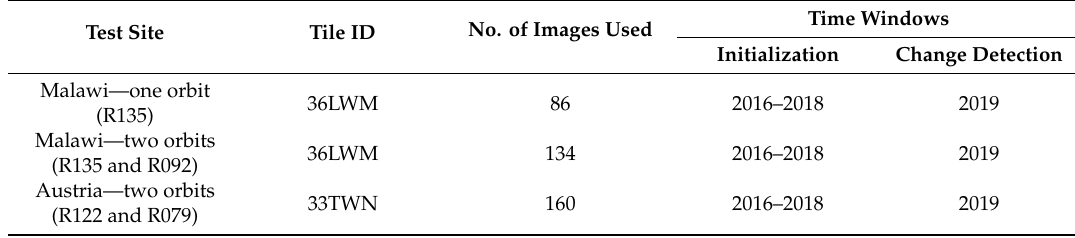
Table 1. Earth ObservationData